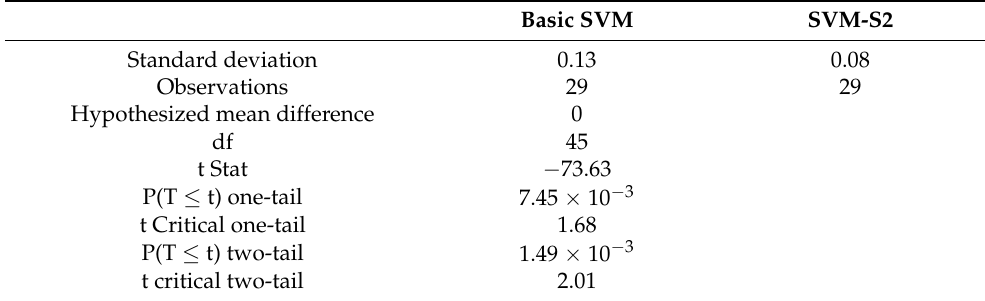
Table A2. t -test: two-sample assuming unequal variances between basic SVM and SVM-S2, simple beam.